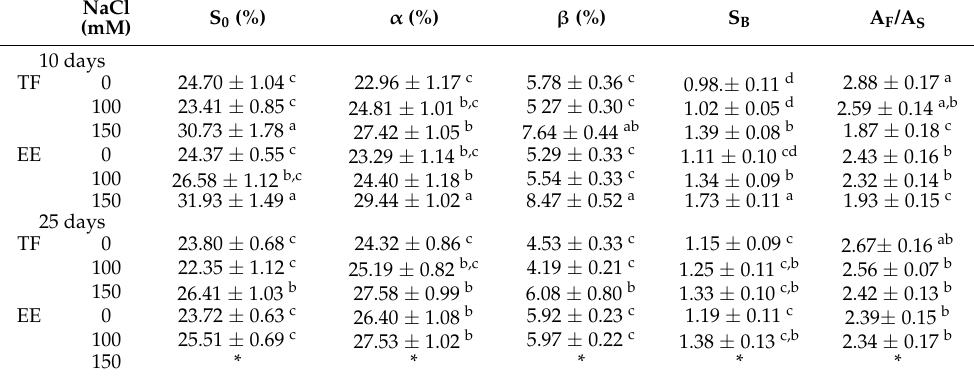
Table 3. Influence of different concentrations of NaCl on the kinetic parameters of oxygen evolution of isolated thylakoid membranes from Paulownia tomentosa x fortunei (TF) and Paulownia elongata x elongata (EE); S 0 —the percentage of PSII centers in S 0 state in the dark; α —misses, β —double hits, S B —the blocked PSII centers and A F /A S —the ratio of fast (PSII α ) to slow (PSII β ) oxygen-evolving PSII centers. The plants were treated with NaCl for 10 and 25 days. Means values ( ± SE) in each column marked with different letters have statistically significant differences at p < 0.05. *—lethal NaCl concentration. NaCl α (%) β (%) S (mM) S 0 (%)